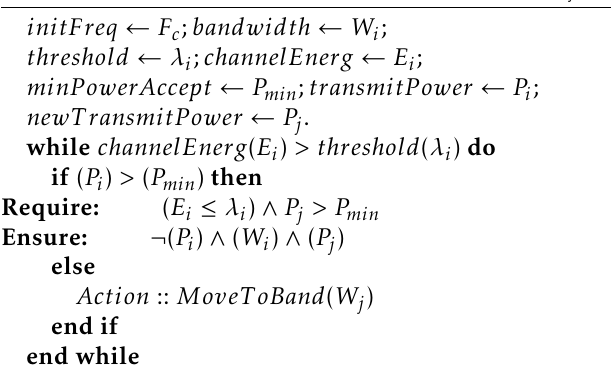
Algorithm 1 Action :: DecreaseT rP ower ( P